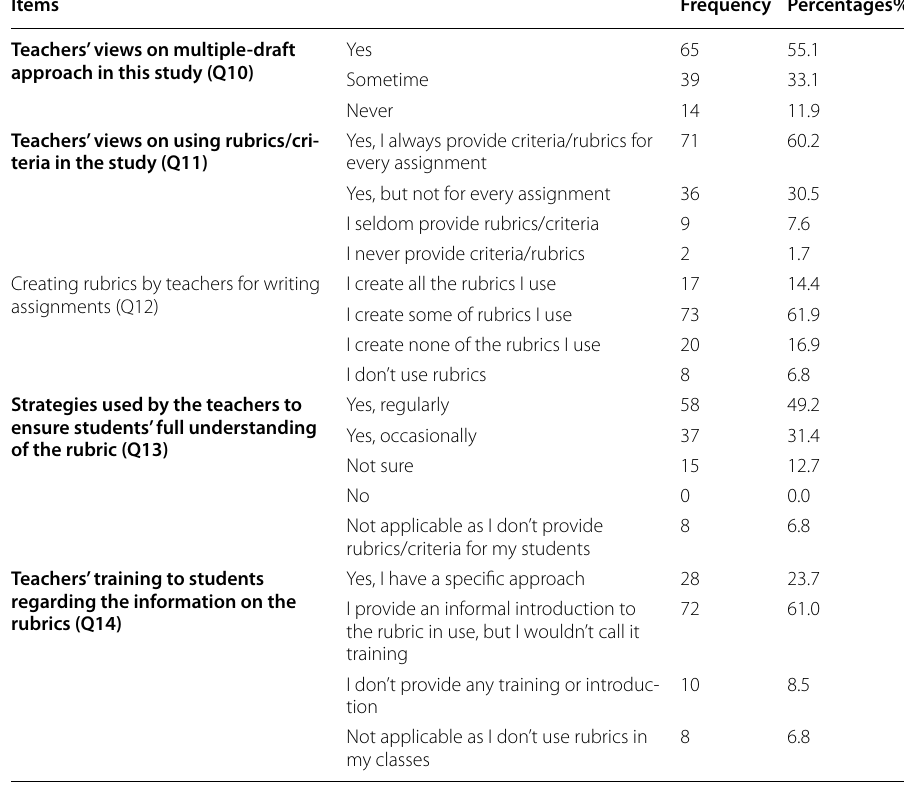
Table 4 Teachers’ views on writing assessment practices in this study Items Frequency